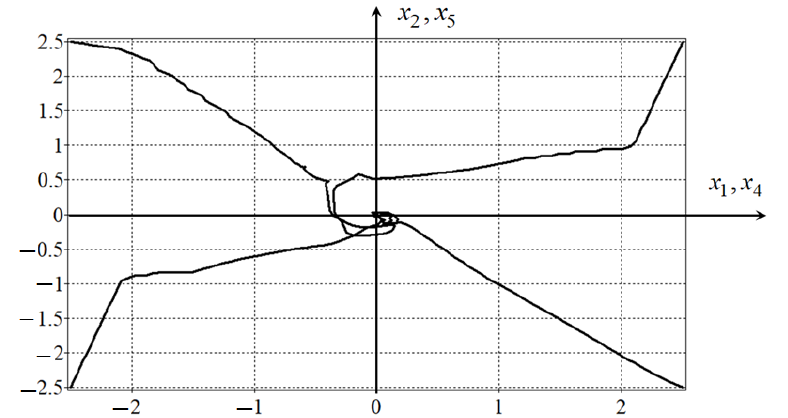
Figure 4. Trajectories on the horizontal plane for four initial